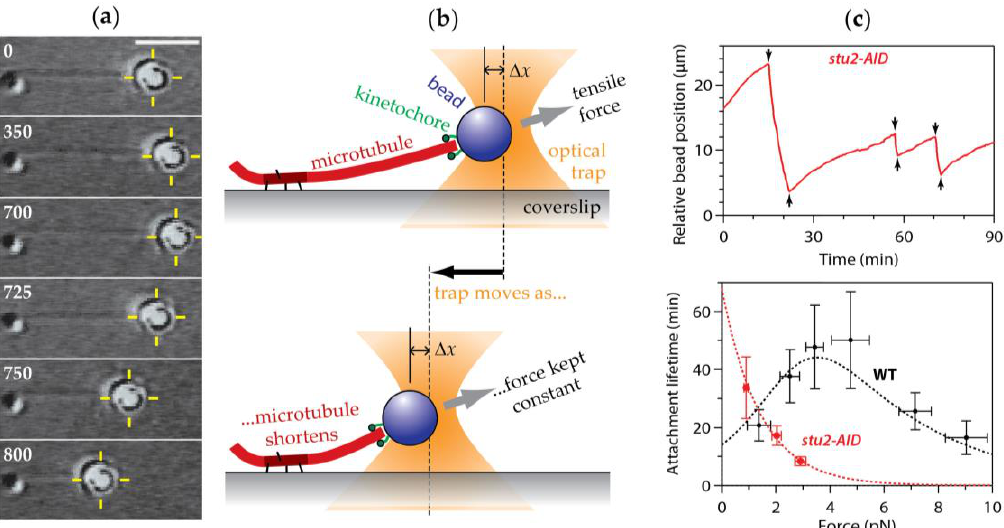
Figure 7. Laser trap assay for studying tip-coupling by purified kinetochore subcomplexes and native kinetochore particles. ( a ) Time-lapse images showing a bead decorated sparsely with native yeast kinetochore particles tracking with microtubule growth (0–700 s) and shortening (700–800 s). The laser trap (yellow crosshair) is moved automatically to keep a constant level of tension (here, ~1 pN) on the kinetochore as it moves with the microtubule tip. Scale bar, 4 μm. ( b ) Cartoon showing force clamp operation. The laser trap is servo-controlled to keep a fixed offset, Δ x , between the trap and the bead, thereby maintaining a constant tensile force. ( c ) Upper plot: Record of position versus time for a native kinetochore isolated from yeast cells depleted of the TOG-family protein, Stu2. Arrows indicate switching of the microtubule tip from growth to shortening ( ↓, ‘catastrophes’) and from shortening back to growth ( ↑ , ‘rescues’). Lower plot: Mean attachment lifetime as a function of force for wild-type (WT, black ) and Stu2-depleted ( stu2-AID , red ) kinetochore particles. Plots in (c) are adapted from [135], and are displayed with permission from Elsevier Publishing (http://www.sciencedirect.com/science/ journal/00928674).